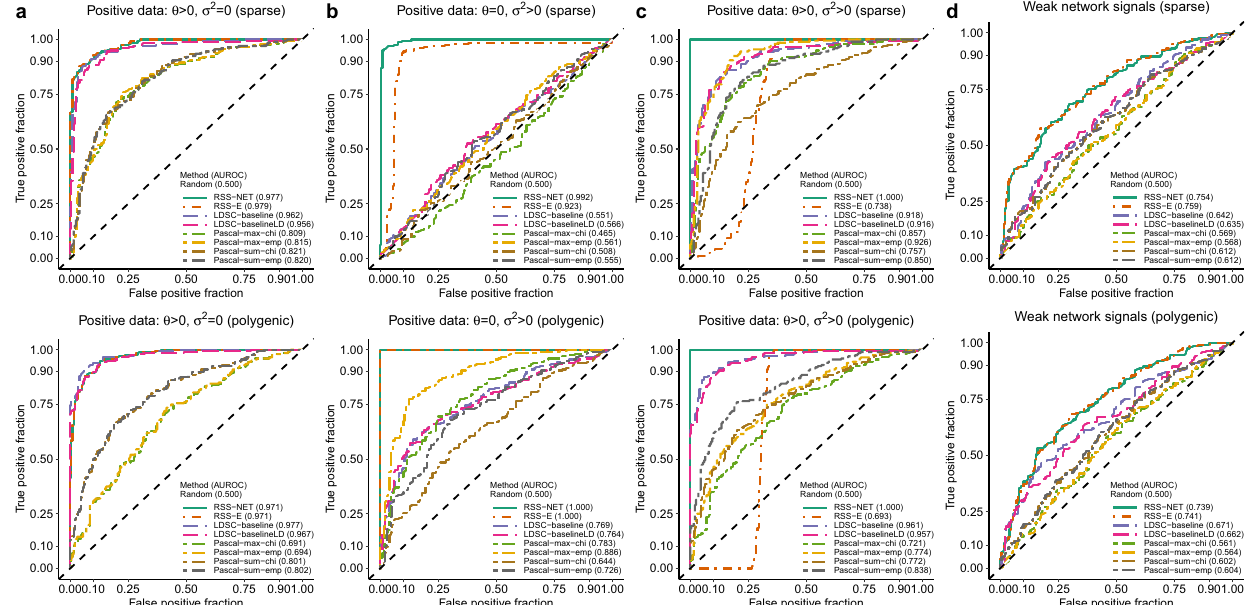
Fig. 2 Flexibility of RSS-NET to identify network-level enrichments from GWAS summary statistics. We used a B cell-speci fi c regulatory network and real genotypes of 348,965 genome-wide SNPs to simulate negative and positive individual-level data under two genetic architectures ( “ sparse ” and “ polygenic ” ). We simulated SNP effects ( β ) for negative datasets from the baseline model ( M θ = 0 and σ 2 = 0). We simulated β for positive datasets 0 : from the enrichment model ( M 1 : θ > 0 or σ 2 > 0) for the target network under three scenarios: a θ > 0, σ 2 = 0; b θ = 0, σ 2 > 0; c θ > 0, σ 2 > 0. Using the simulated individual-level data we computed single-SNP association statistics, on which we compared RSS-NET with RSS-E 16 , LDSC-baseline 13 , LDSC- baselineLD 27 , and Pascal 26 using their default setups (Methods). Pascal includes two gene ( “ max ” : maximum-of- χ 2 ; “ sum ” : sum-of- χ 2 ) and two pathway ( “ chi ” : χ 2 approximation; “ emp ” : empirical sampling) scoring options. For each dataset, Pascal and LDSC methods produced P -values, whereas RSS-E and RSS-NET produced BFs; these statistics were used to rank the signi fi cance of enrichments. A false and true positive occurs if a method identi fi es enrichment of the target network in a negative and positive dataset respectively. Each panel displays the trade-off between false and true positives via receiver operating characteristics (ROC) curves for all methods in 200 negative and 200 positive datasets of a simulation scenario, and also reports the corresponding areas under ROC curves (AUROCs, higher value indicating better performance). Dashed diagonal lines denote random ROC curves (AUROC = 0.5). d RSS-NET, as well as other methods, does not perform well when the target network harbors weak genetic associations. Simulation details and additional results are provided in Supplementary Figs. 1,